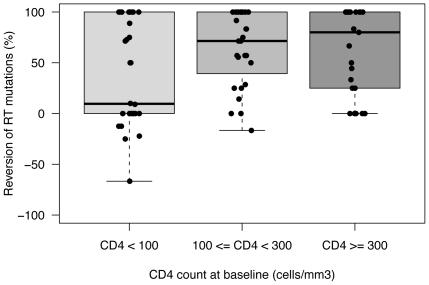
RT reversion rate by baseline CD4 strata.The reversion rate was calculated as the proportion of RT mutations reverting to wild-type codon divided by the number of RT mutations at baseline for each patient. Patients with lower CD4+ cell count at baseline (CD4<100) showed fewer reversion of RT mutations, the median proportion of RT mutations reverting for this group was 9.5%, compared to over 75% in the other groups.